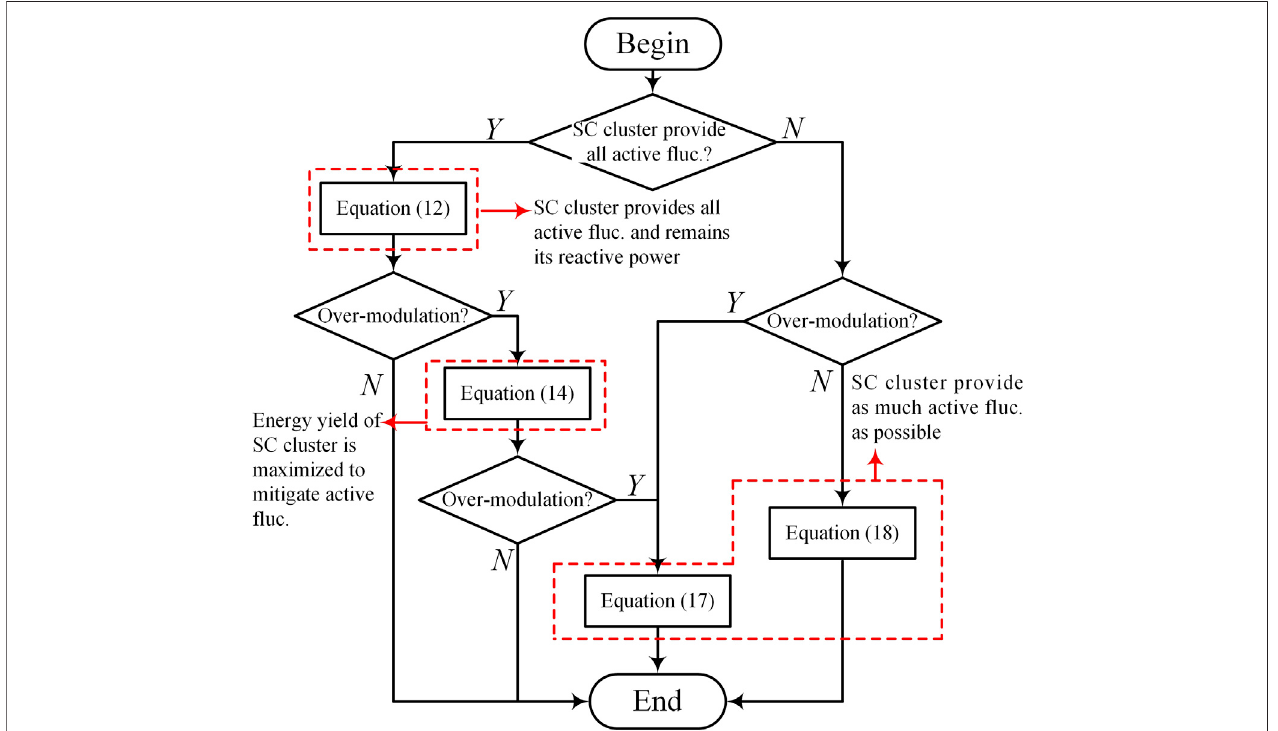
FIGURE 7 | Flowchart of power distribution algorithm for power compensation